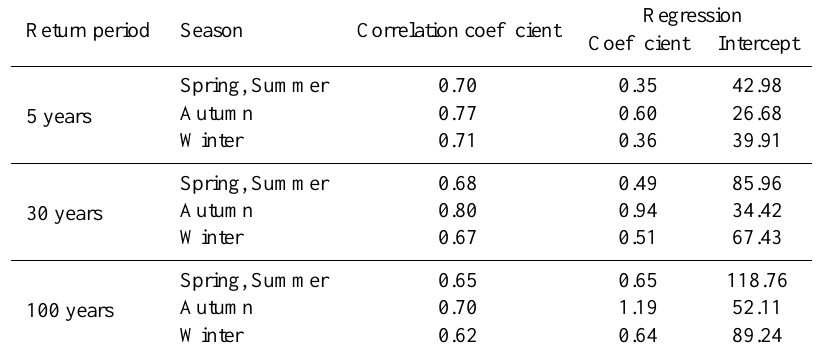
Table 2. Correlation between maximum monthly precipitation and the extreme precipitation of 5 years, 30 years and 100 years return period.